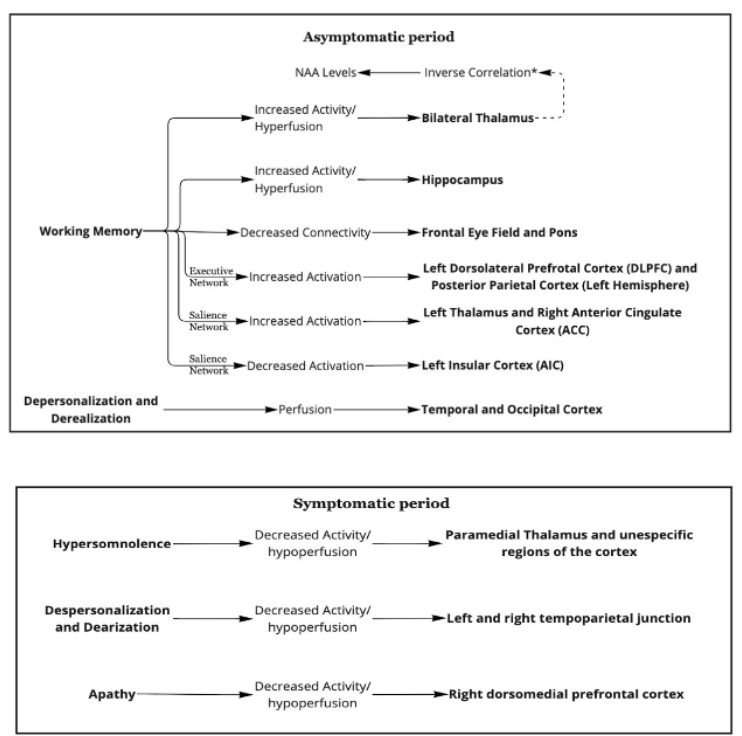
Figure 2. A graphic summary of the paper. * Greater activity in the thalamus is correlated with lower NAA NAA levels.